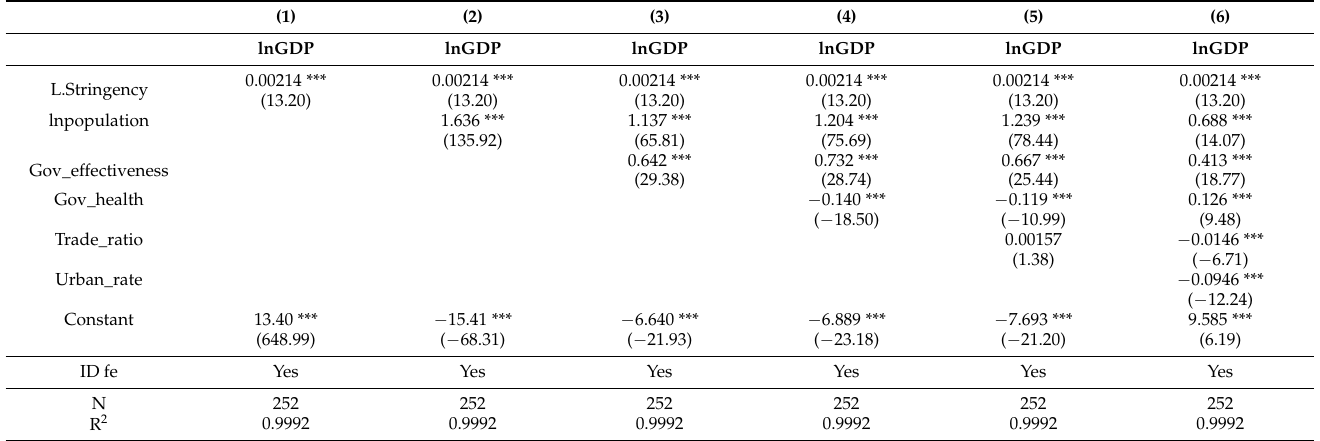
Table 6. Long-term economic recovery impact of